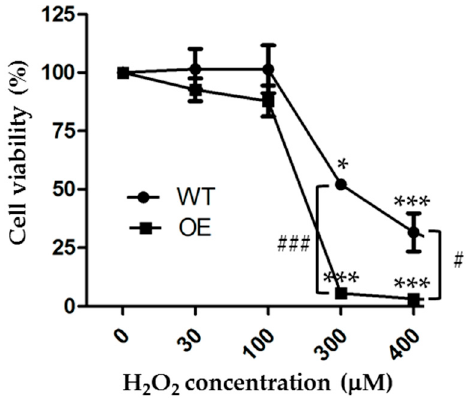
Figure 5. Increasing the TRPM2 expression in SH-SY5Y cell enhances H 2 O 2 -induced reduction in cell viability. Mean ± SEM cell viability, as a percentage of that under control conditions, in the WT and TRPM2-overexpressing (OE) cells after exposure to indicated concentrations of H 2 O 2 for 24 h. The results were from three independent experiments. *, p < 0.05 and ***, p < 0.001, compared to cells without exposure to H 2 O 2 in the WT or OE cells, respectively; #, p < 0.05 and ###, p < 0.001 compared between the WT and OE cells treated with the same concentration of H 2 O 2 .